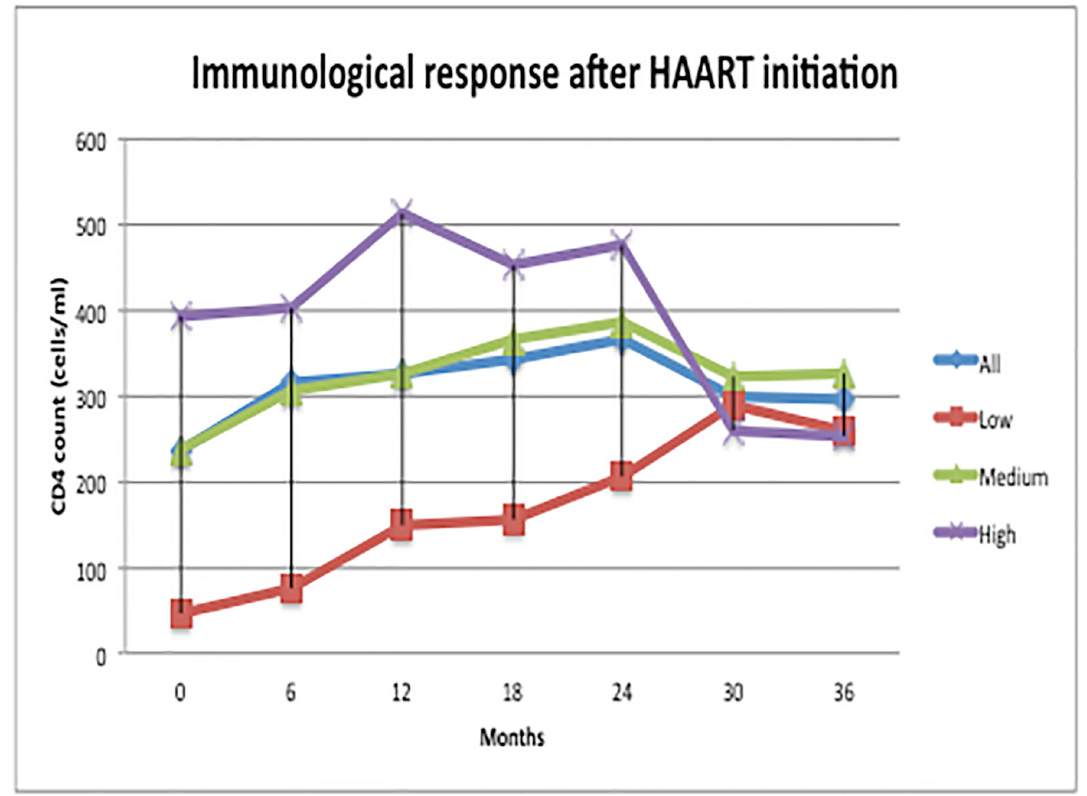
Fig 2. Immunological recovery after ART initiation stratified by baseline CD4